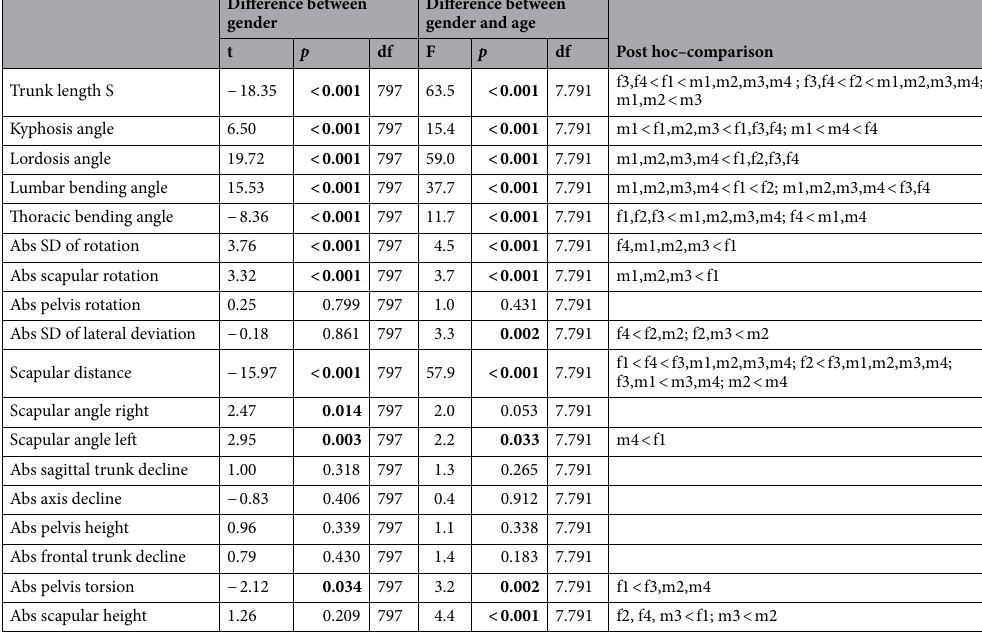
Table 5. Sex and age specific differences based on the predefined groups. The post hoc comparison shows differences between female (f) and male (m) subjects according to the four age groups: 1: 21–30 years; 2: 31–40; 3: 41–50; 4: 51–60. If Abs is placed in front of a parameter, only the absolute values are integrated into the calculations, i.e. only the extent without the direction of movement. Significant variables are highlighted in bold.